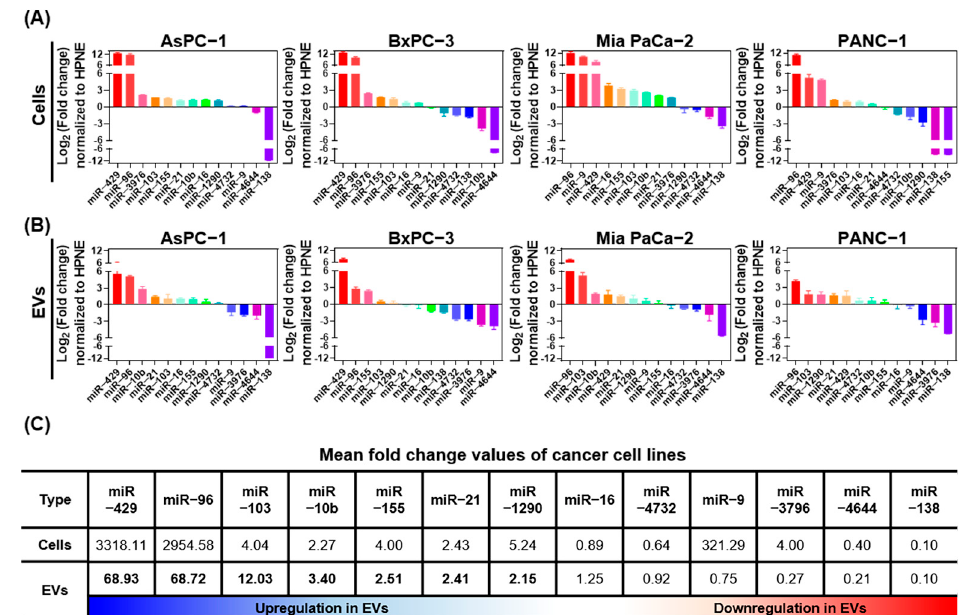
Figure 4. Bar charts showing fold changes in miRNA expression in pancreatic cancer cells and EVs normalized to expression in HPNE cells and EVs. Thirteen candidate miRNAs were analyzed in ( A ) cells and ( B ) EVs by real-time quantitative PCR. ( C ) Mean fold change of miRNA expression in AsPC − 1, BxPC − 3, Mia PaCa − 2, and PANC − 1 cancer cells and EVs normalized to expression in HPNE cells and EVs. miRNAs that were upregulated in EVs are shown in bold.